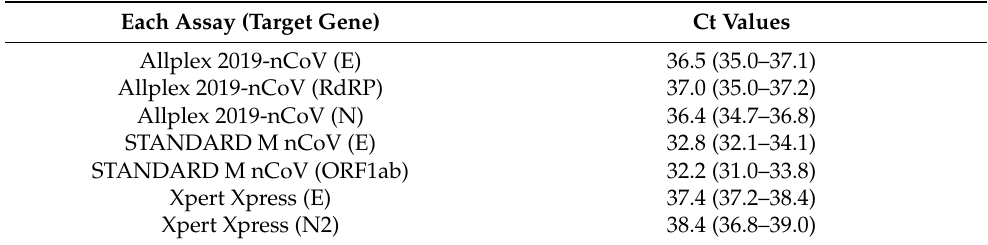
Table 3. Ct values of three discrepant results showing negative only in STANDARD M10. Each Assay (Target Gene) Ct